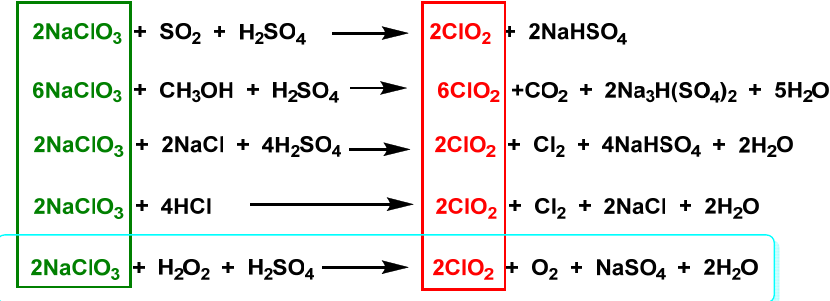
Figure 5. Preparation of chlorine dioxide from sodium chlorate.